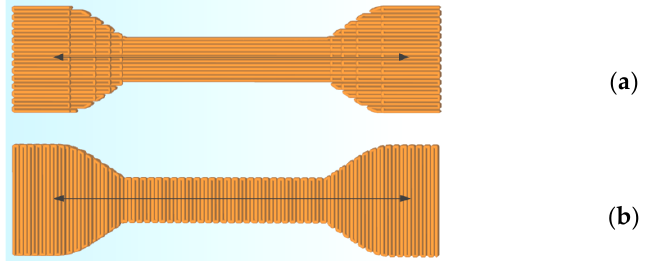
Figure 9. Material stream orientation: ( a ) — Y direction, ( b ) X — direction. Table 4. Typical properties of PETG foam.